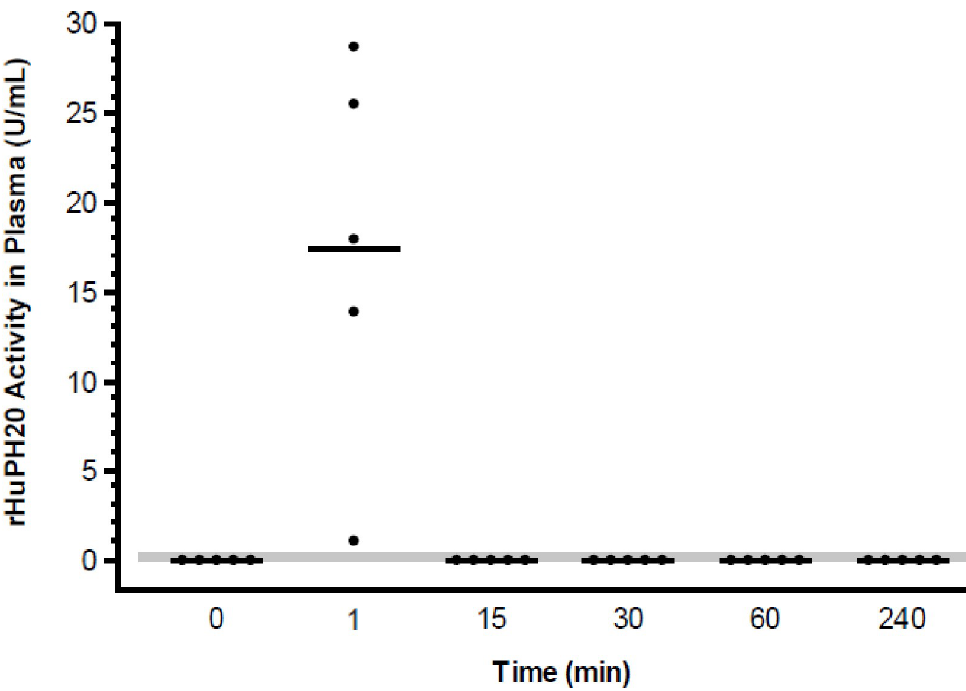
Fig 4. Concentration-time course of rHuPH20 in plasma samples following IV administration. rHuPH20 concentration (U/mL) in plasma samples from individual animals (filled circles) are depicted as well as the mean (line) for each time point. Values lower than the LLOQ ( < 0.3 U/mL; shaded area) are plotted as 0. IV, intravenous; rHuPH20, recombinant human hyaluronidase PH20; LLOQ, lower limit of quantitation.